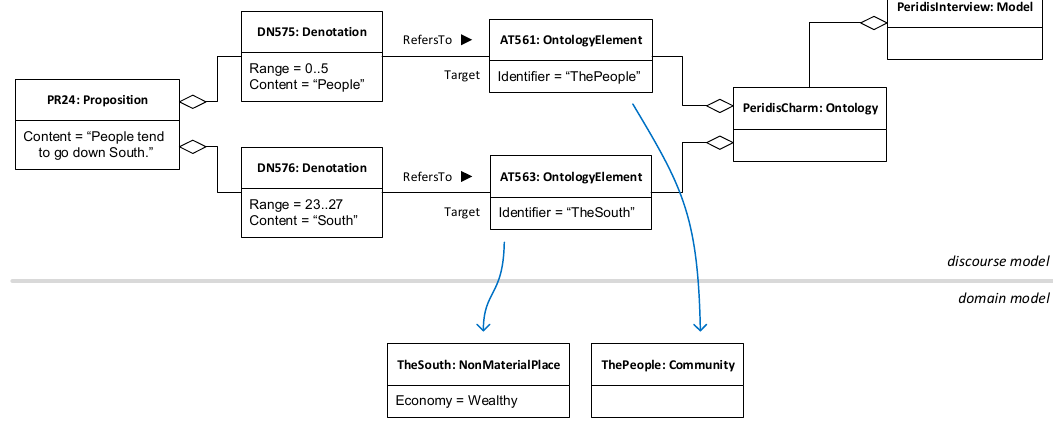
Figure 6. Diagram depicting how ontological proxies work. Above the line, an instance model conforming to the metamodel in Figure 5 is shown, stating that proposition PR24 has two denotations for “People” and “South”. Each denotation refers to a particular ontological element of the discourse model’s associated domain model (ontology). Below the line, a fragment of the associated domain model from Figure 3 is shown. Blue arrows across the line depict the fact that ontological elements work as proxies to elements in the domain model, as shown by the matching identifiers “ ThePeople ” and “ TheSouth ”.